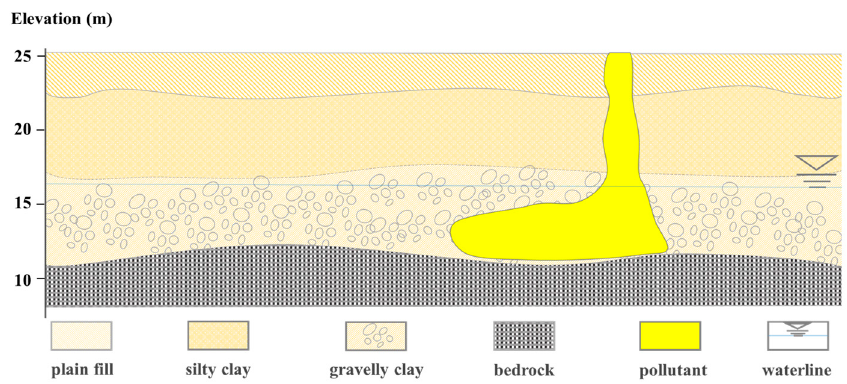
Figure 2. The stratigraphic structure in the study area.